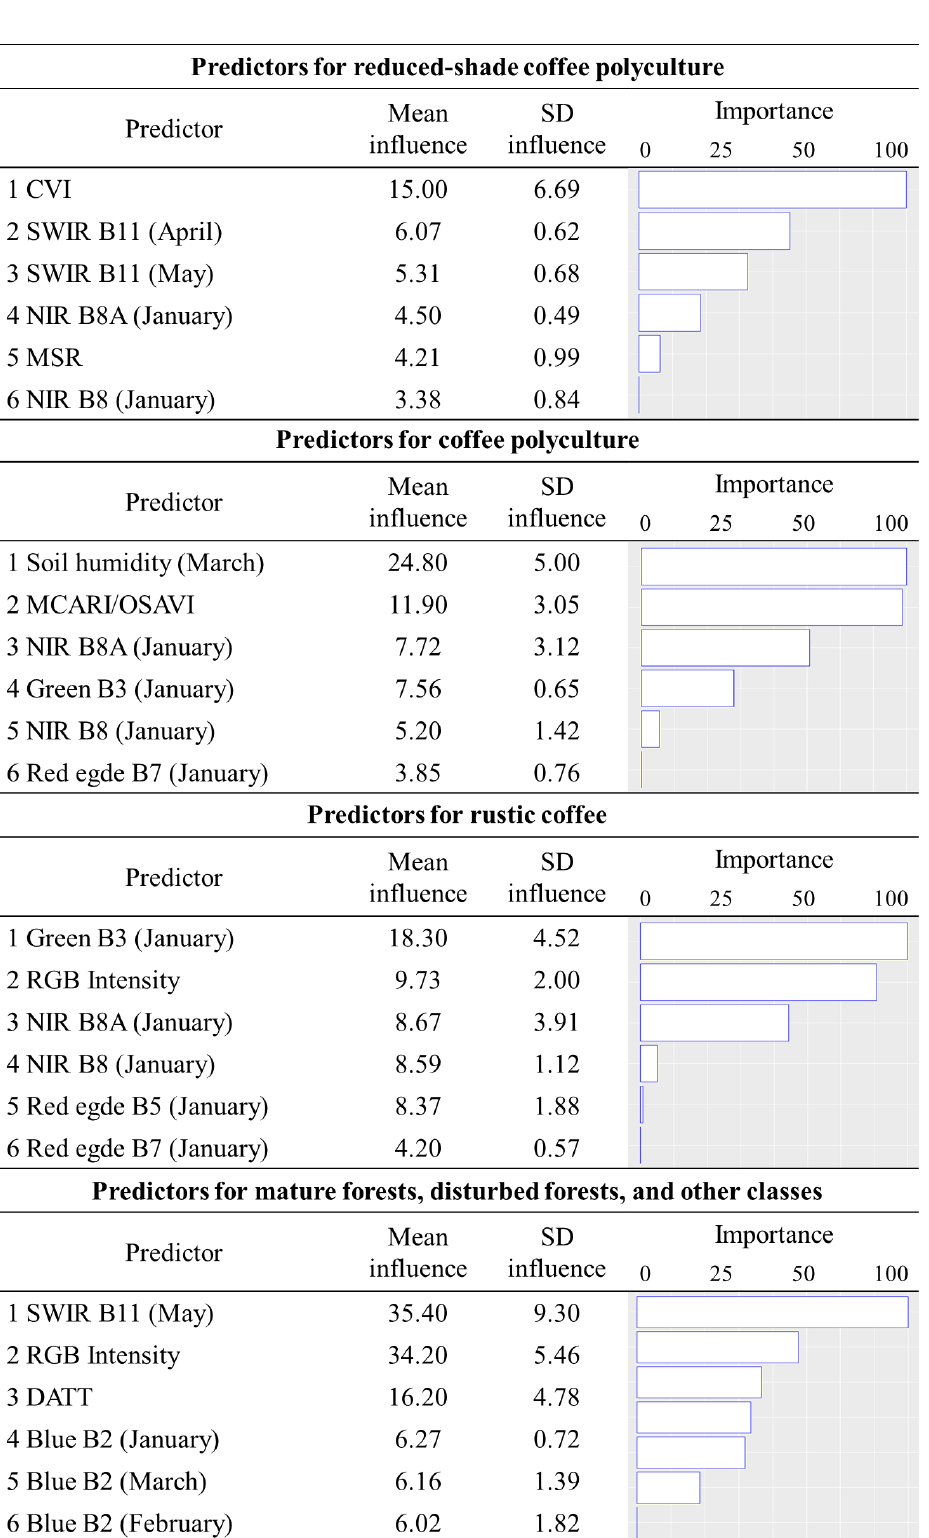
Figure 4. Predictors and their influence for each class in the RF classification. SD = standard deviation. The optimal parameters for the random forest classification models ( mty = 3 and ntree = 500) achieved accuracy values above 98% for the three AFS models and above 99% for the other land-cover